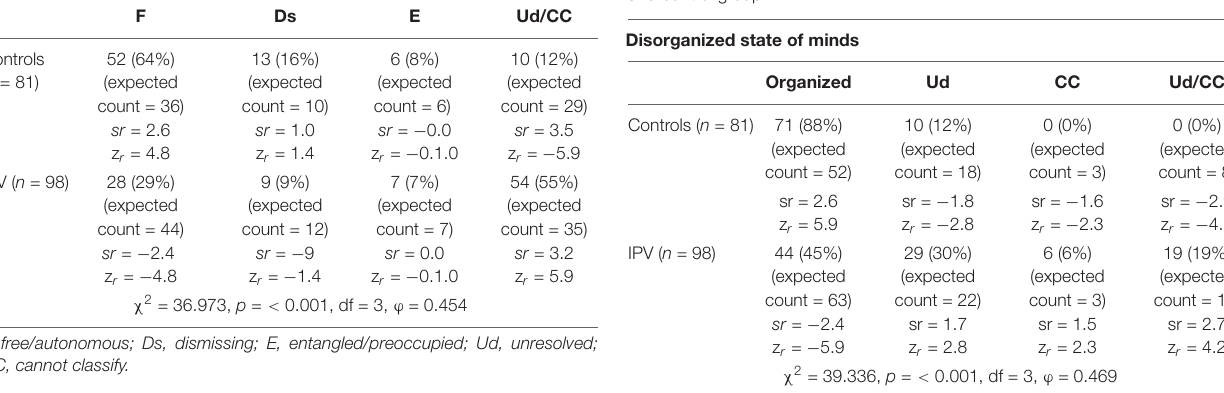
TABLE 5 | Sub-types of disorganized states of minds at the AAI in the IPV and control group.